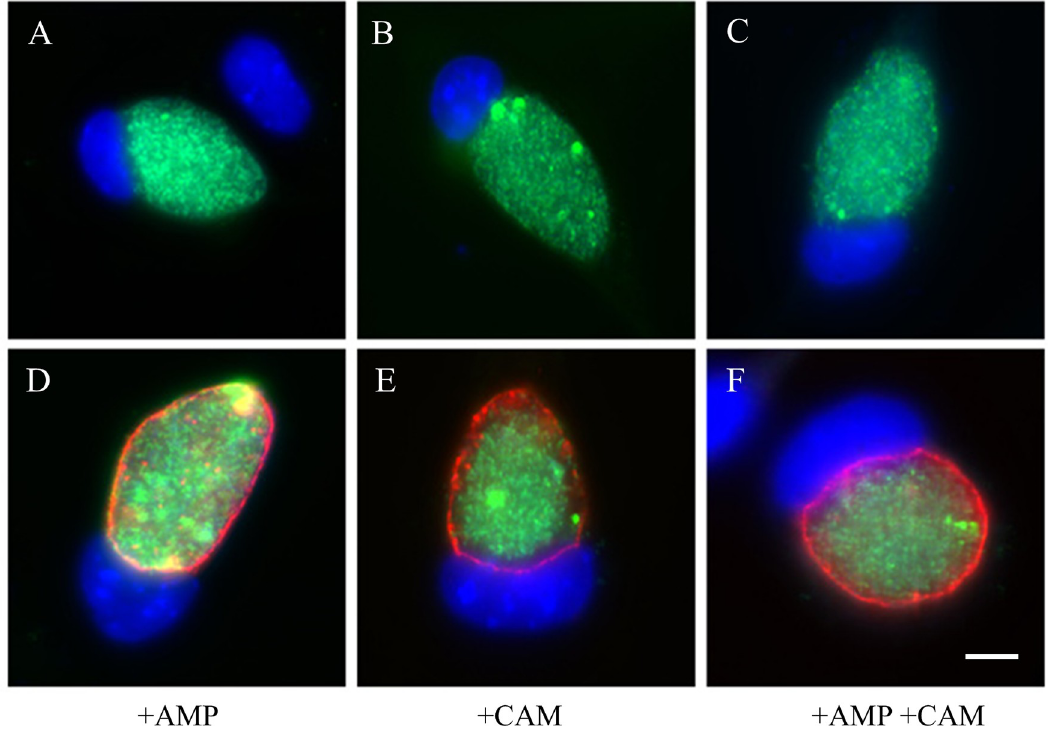
Fig 1. Immunofluorescence images of pBVR2 transformants show GFP and IncA expression. GFP fluorescence of chlamydial inclusions was visualized in live cells prior to fixing and staining. Infected McCoy cells were fixed with 100% MeOH at 48hpi. All cells were stained with DAPI to visualize host cell nuclei (blue). (A-C) Unlabeled GFP positive bacteria. (D-F) Cells labeled with antibodies to C . trachomatis IncA (red). (A, D) Cells treated with 100 μ g/ml Amp only. (B, E) Cells treated with 1 μ g/ml Cm only. (C, F) Cells treated with 100 μ g/ml Amp and 1 μ g/ml Cm. Scale bar represents 5 μ